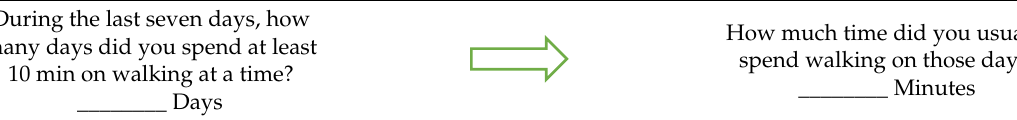
Box A1. Physical